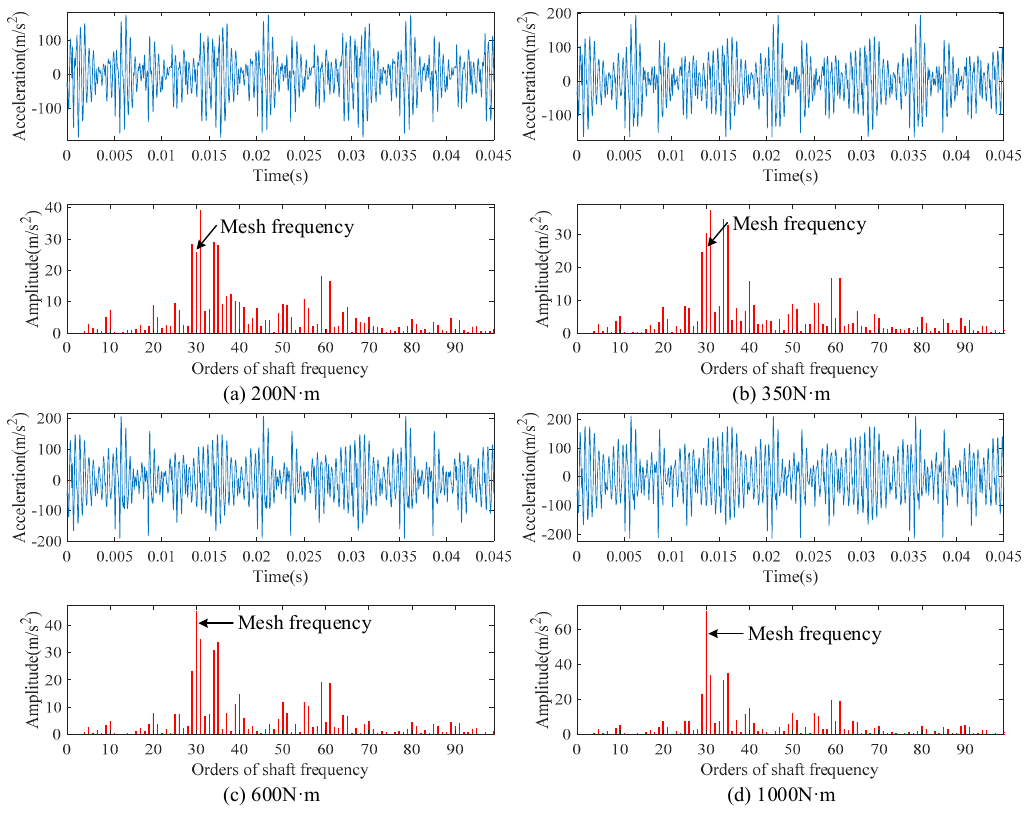
Figure 12. Bearing vibration acceleration at di ff erent load torques considering random cumulative pitch deviations.